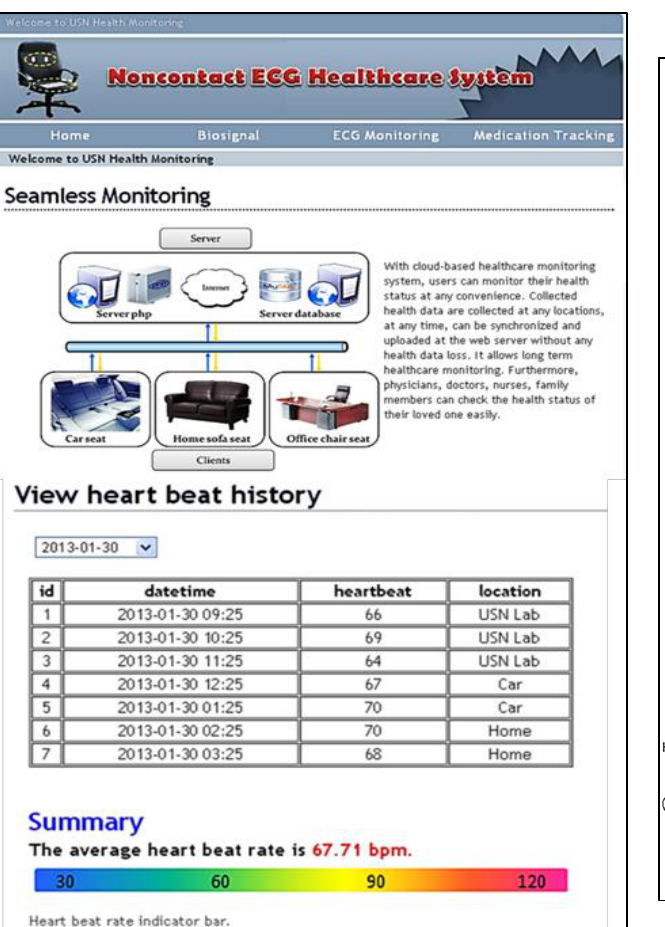
Figure 16. Operational Web page for the noncontact health system for real-time health evaluation wherever a cellular network coverage is present. ( a ) JavaScript dropdown list to view the history and summary of the HR on the Web page; ( b ) HR records and HR plotting on the Web